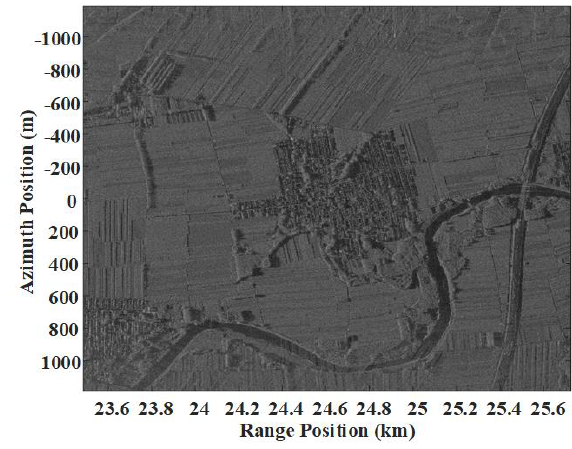
Figure 5. Imaging result of airborne SAR raw echo data.